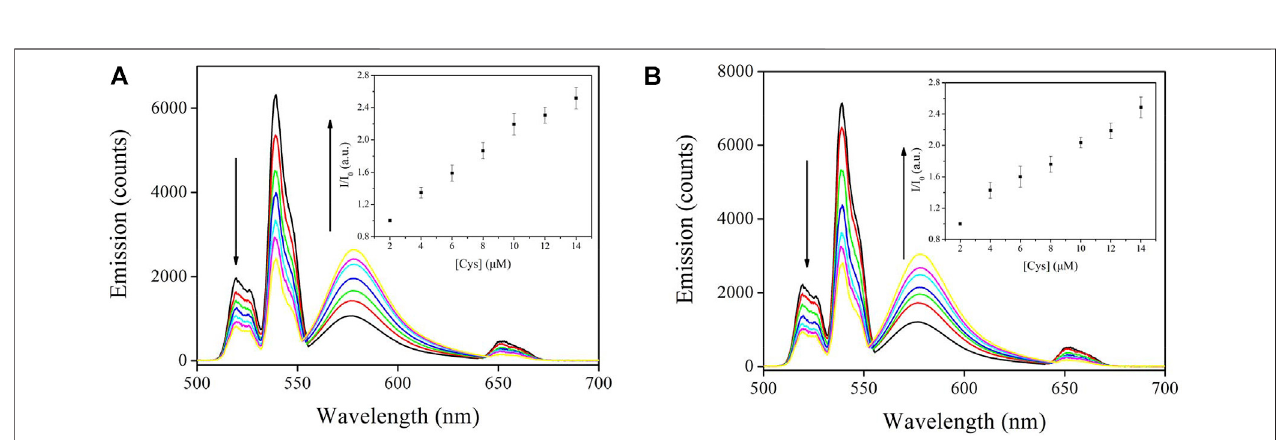
FIGURE 8 | (A) Emission spectra of Lattice:Sensor-1 upon various Cys concentrations using NaYF 4 :Yb 3+ /Er 3+ nanocrystals as the excitation host (in PBS, pH = 7.0,5 mgin10 mlforhost,10 μ MforChemosensor1, λ ex =980 nm).Inset:correspondingI/I 0 vs. [Cys]variation. (B) Emission spectraofLattice:Sensor-2uponvarious CysconcentrationsusingNaYF 4 :Yb 3+ /Er 3+ nanocrystalsastheexcitationhost(inPBS,pH=7.0,5 mgin10 mlforhost,10 μ MforChemosensor2, λ ex =980 nm).Inset: corresponding I/I 0 vs. [Cys]